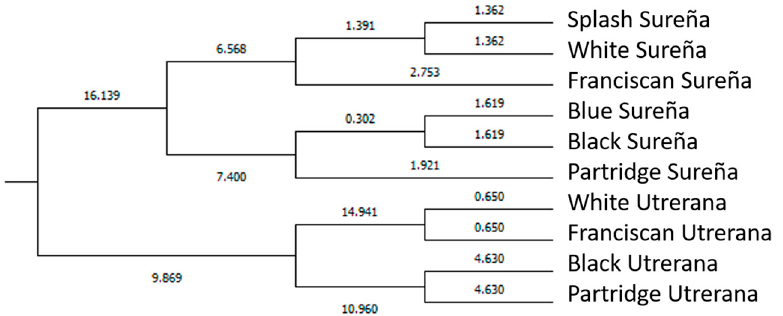
Figure 5. Cladogram constructed from Mahalanobis distances across different genotypes (breed/varieties) in female population.